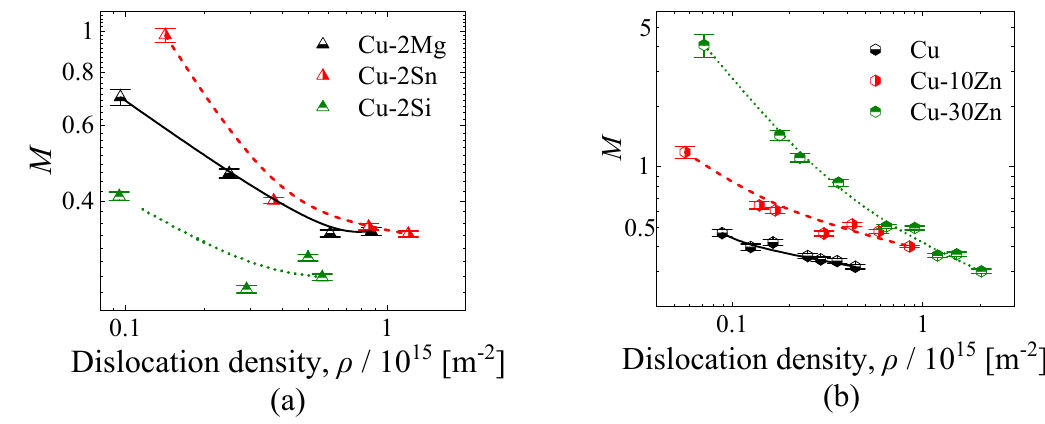
Figure 15. Influence of varying dislocation density on M values for ( a ) Cu-2 X and ( b ) Cu- x Zn specimens ( X = Mg, Sn, Si; x , in mass% = 0, 10, 30.).